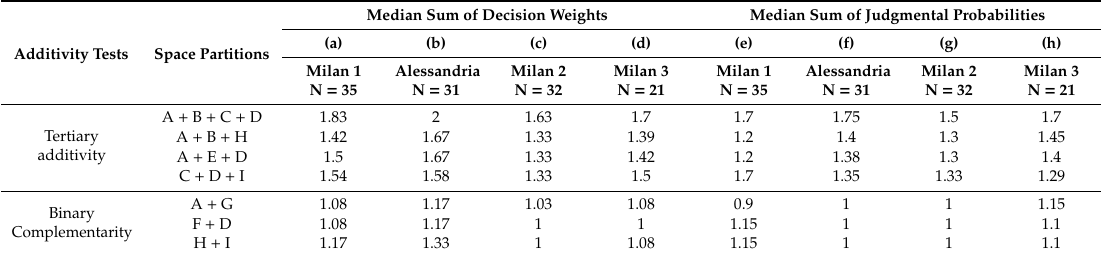
Table 2. Uncertain lotteries: Median values across individuals of the additivity